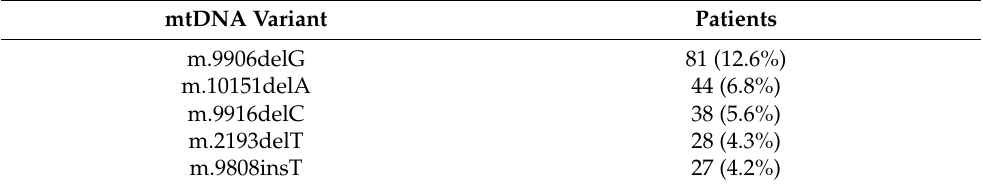
Table 3. Top-5 most frequent non-ancestral indels. Columns from left to right: mtDNA sequence variant, number of patients and frequency.